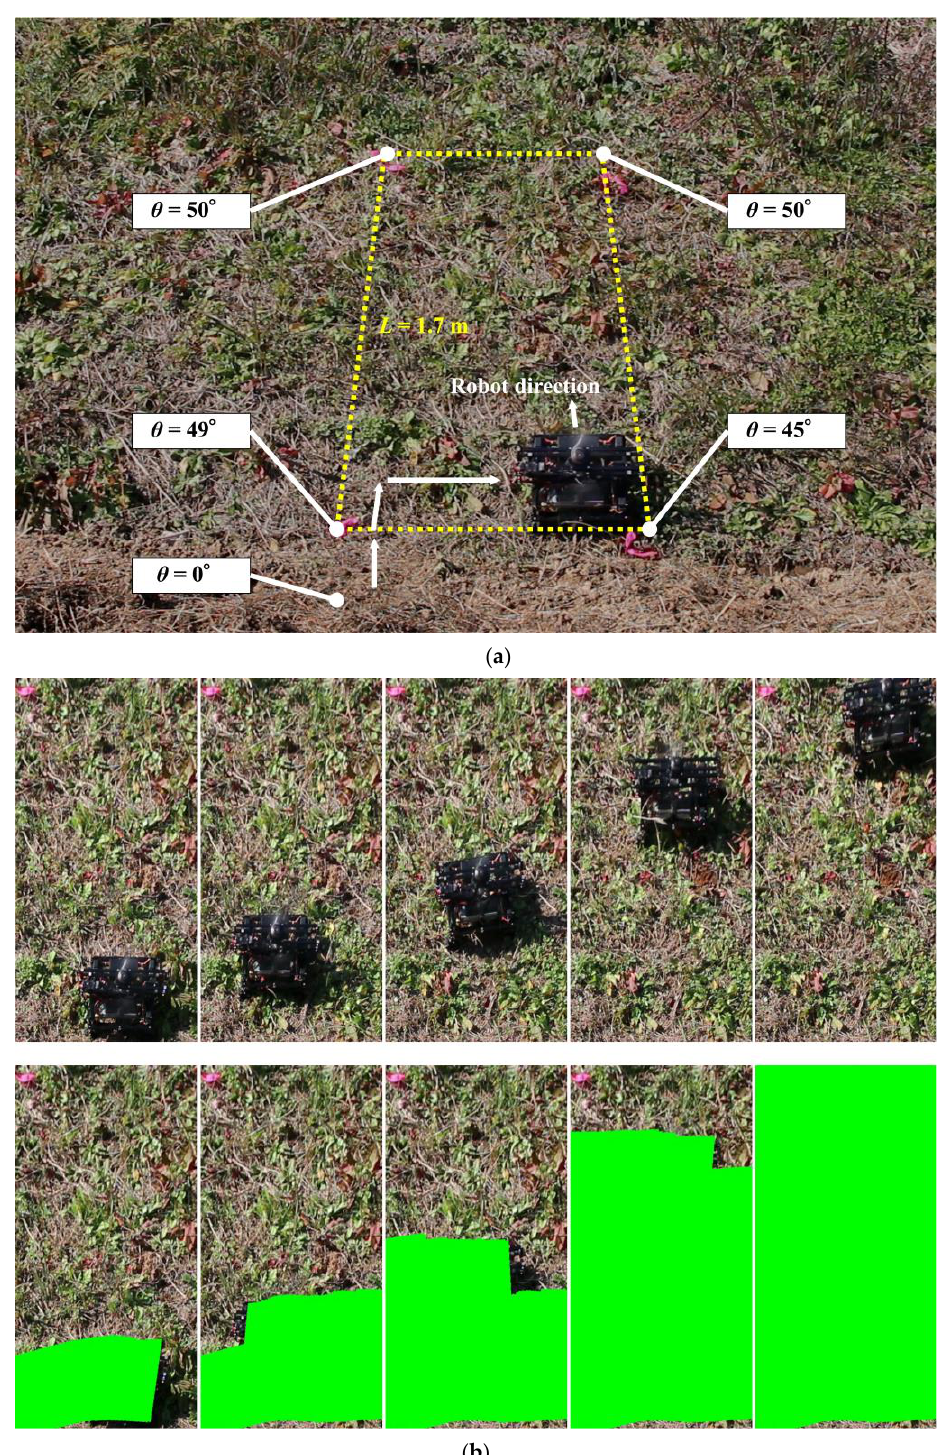
Figure 14. Coverage area on a grassy slope. ( a ) Target area on a slope with an inclination of 45 – 50°. ( b ) Coverage process of the robot at different points in time.